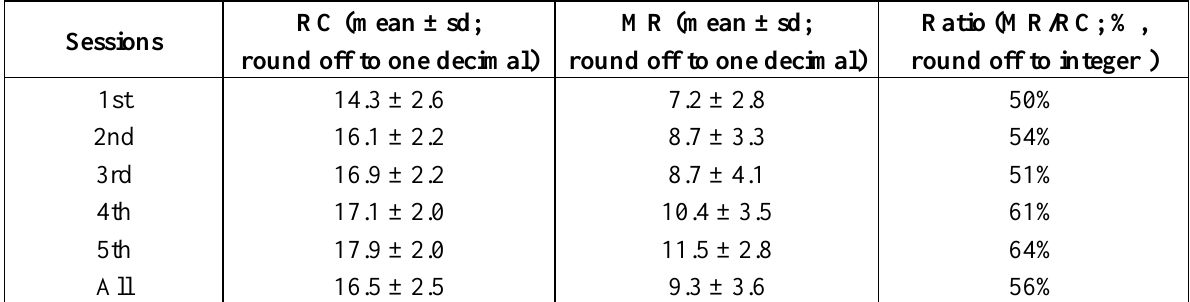
Table 3. Tasks completed using MR and RC for all 18